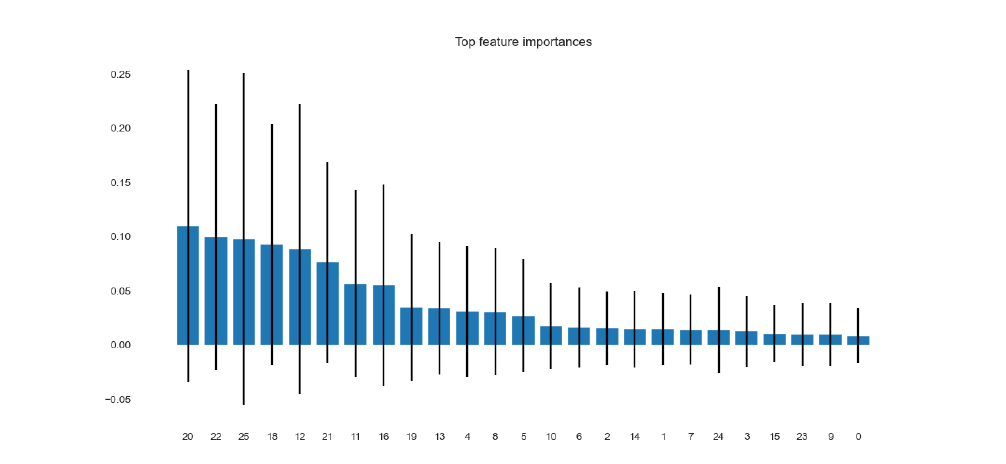
Figure 4. Pearson’s r correlation.